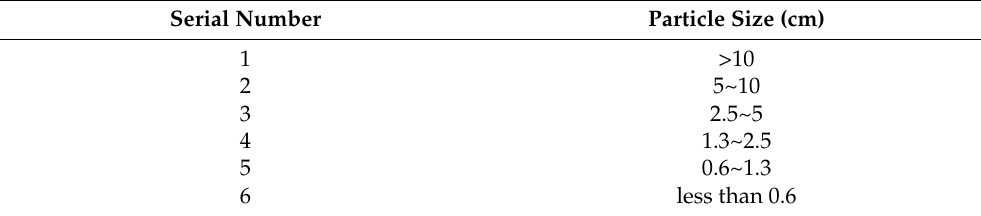
Table 1. Coal particle size classification.